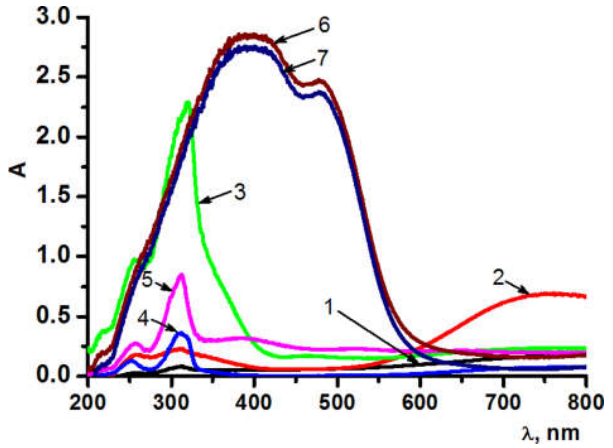
Figure 2. UV–Vis diffuse reflectance spectra of: 1—SN 50 -Cu II , 2—SN 120 -Cu II , 3—Co III @SN 50 -Cu II , 4—Co III @SN 120 -Cu II , 5—Co II @SN 50 -Cu II , 6—SN 50 -Fe III , 7—Co III @SN 50 -Fe III